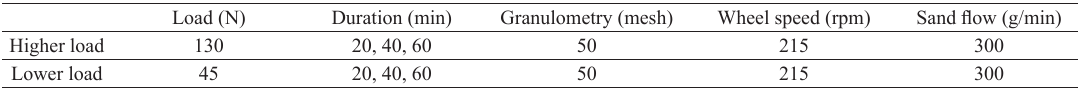
Table 3. Wear test parameters.